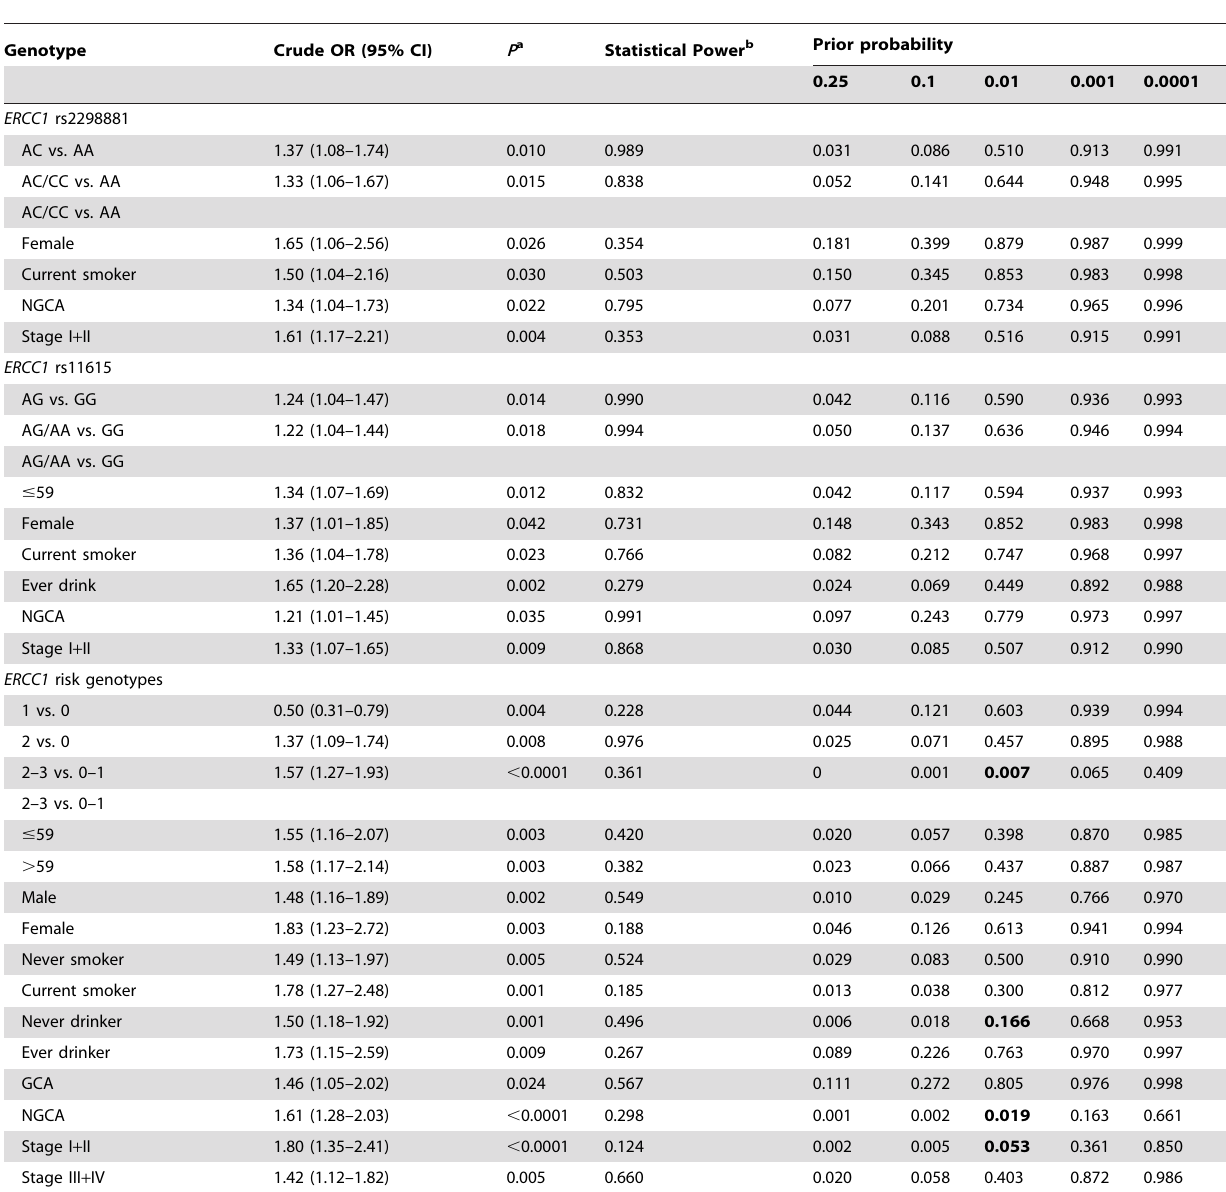
Table 3. False-positive report probability values for associations between the risk of gastric cancer and the frequency of genotypes of the ERCC1